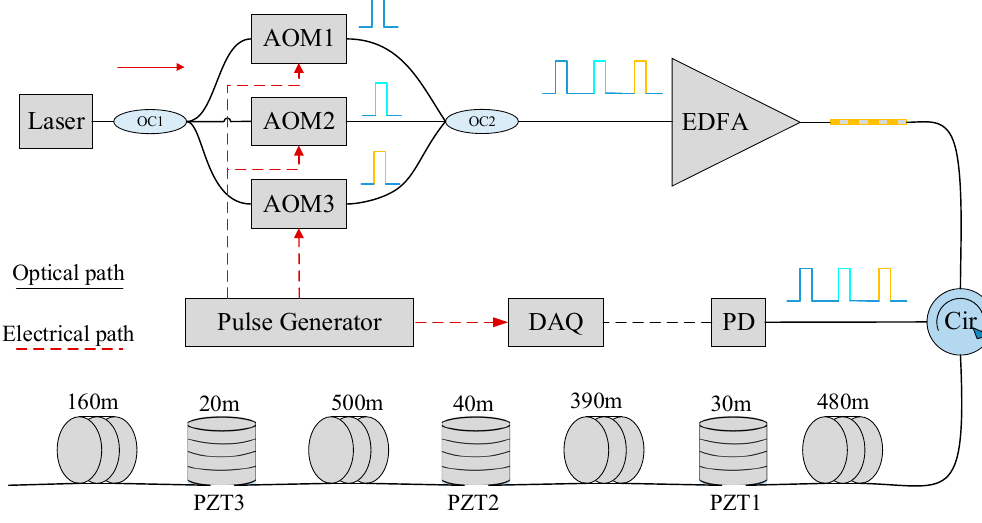
Figure 7 The scheme of proposed Φ -OTDR sensing system Ⅱ. Figure 7. The scheme of proposed Φ -OTDR sensing system